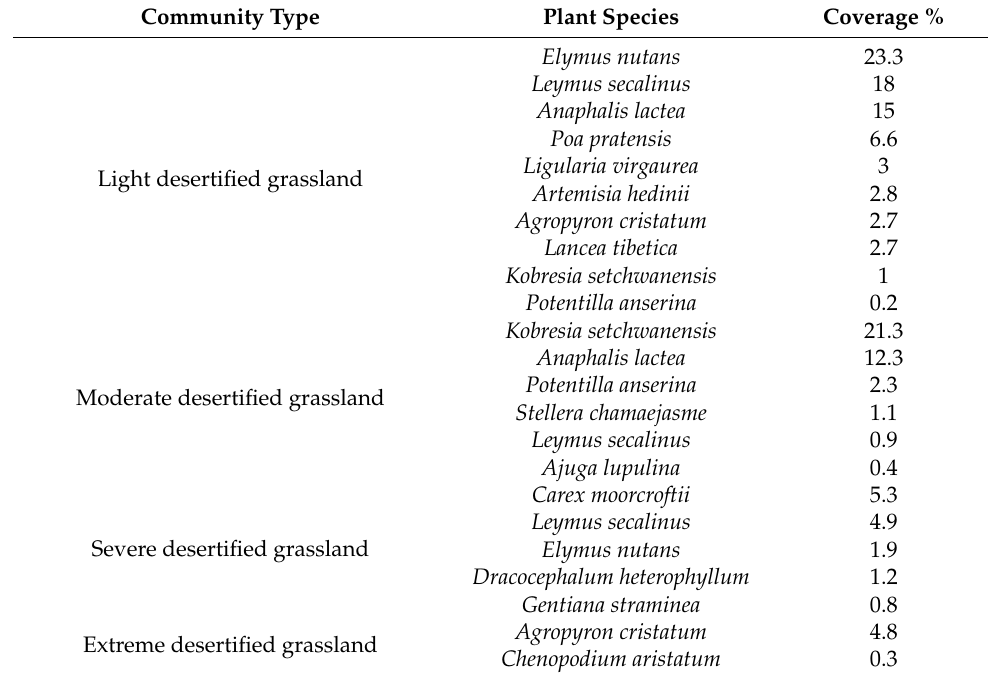
Table 2. Plant species and coverage of different desertification grasslands. Community Type Plant